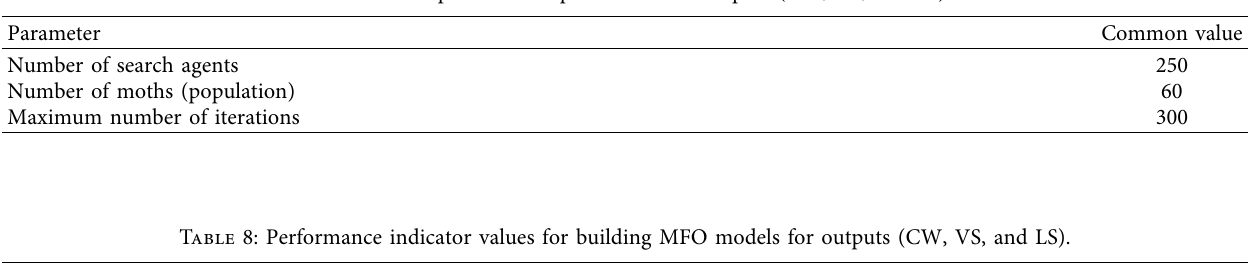
Figure 13: MSE calculated by GWO for predicting. (a) Crack width (CW), (b) volumetric shrinkage (VS), and (c) linear shrinkage (LS). Table 7: The optimal MFO parameters for outputs (CW, VS, and LS).